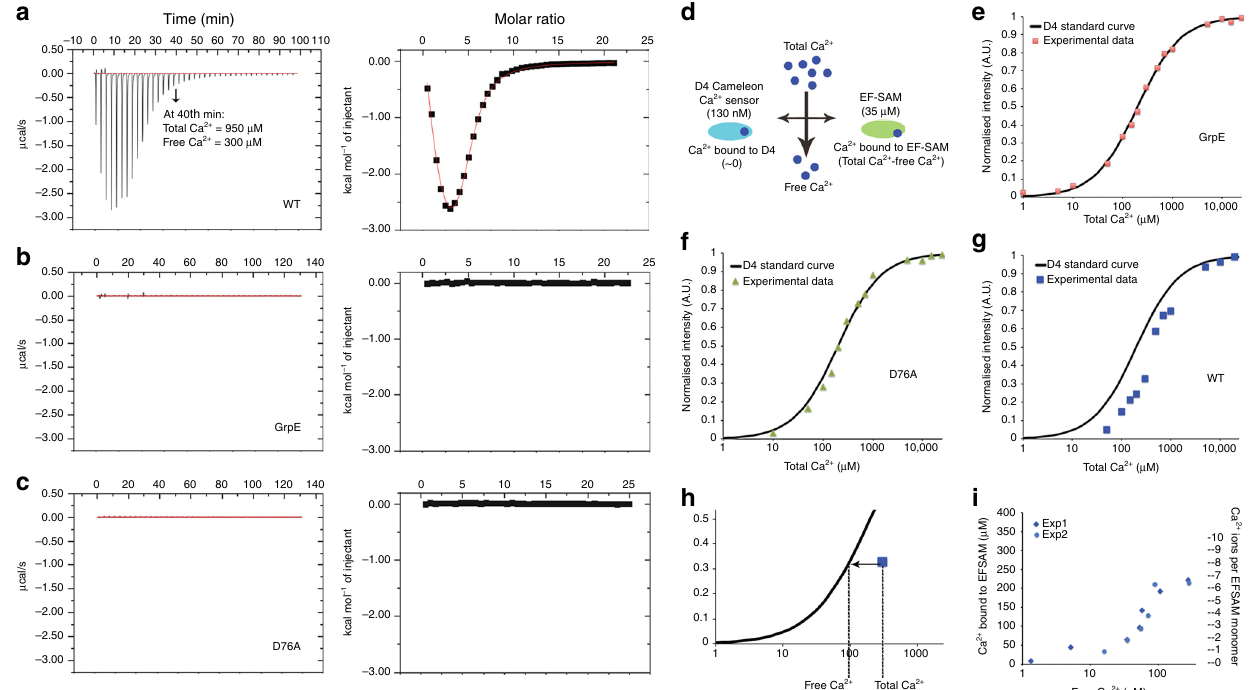
Fig. 3 Multiple Ca 2 + -binding sites in EFSAM. a – c Isothermal titration calorimetric (ITC) analyses of EFSAM-GrpE WT ( a ), GrpE ( b ), and EFSAM-GrpE D76A ( c ). Left panels, Heat changes measured by injecting 1 μ l aliquots of 13 mM Ca 2 + into a sample cell containing initially 130 μ M protein, stated as the monomer concentration. Right panels, Integrated binding isotherm as a function of molar ratio (Ca 2 + : protein) after subtracting heats of dilution. In a , the indicated total Ca 2 + at 40 min is the amount added to the ITC cell up to that point, corrected for the increase in volume, and free Ca 2 + is calculated as total Ca 2 + minus bound Ca 2 + assuming fi ve sites are occupied in EFSAM. d D4 sensor Ca 2 + competition assay design. e – g D4 sensor normalized fl uorescence signals in the presence of GrpE (35 μ M) ( e ), EFSAM(D76A)-GrpE (35 μ M) ( f ), or WT EFSAM-GrpE (35 μ M) ( g ) are compared to the Ca 2 + -binding curve of D4 alone (black solid trace in each panel). h Method used for calculating free Ca 2 + and Ca 2 + bound to EFSAM (as total Ca 2 + minus free Ca 2 + ) from the competition data in g . i Plot of Ca 2 + bound to WT EFSAM as a function of free Ca 2 + concentration, calculated as in h . Data from two experiments plotted